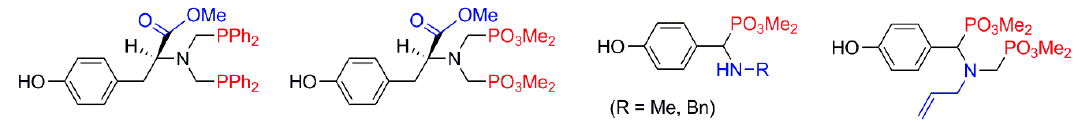
Figure 16. Examples of bifunctional phenols used for the grafting to P(S)Cl 2 terminal functions of dendrimers.